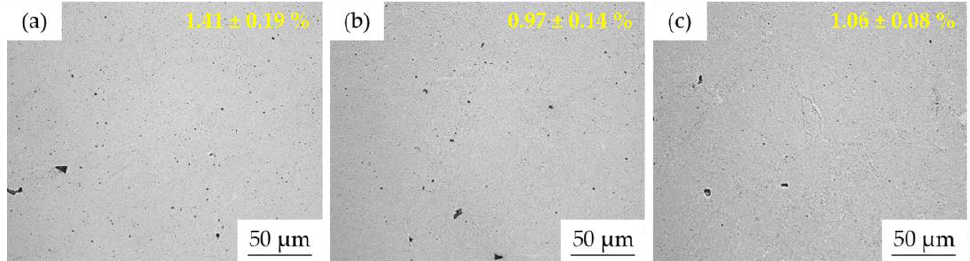
Figure 6. LM micrographs of the MA + SPS alloys with marked surface porosity determined using threshold method: ( a ) Mn15Al5, ( b ) Mn10Al10, ( c ) Mn5Al15. threshold method: ( a ) Mn15Al5, ( b ) Mn10Al10, ( c )